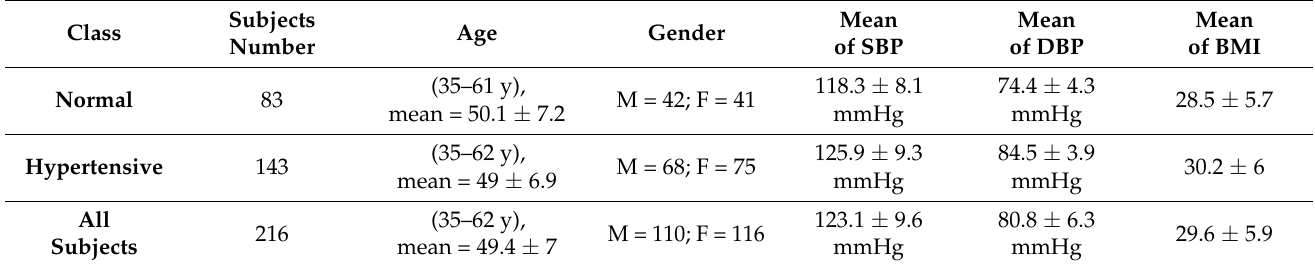
Table 2. Diastolic BP-based dataset demographics statistics.